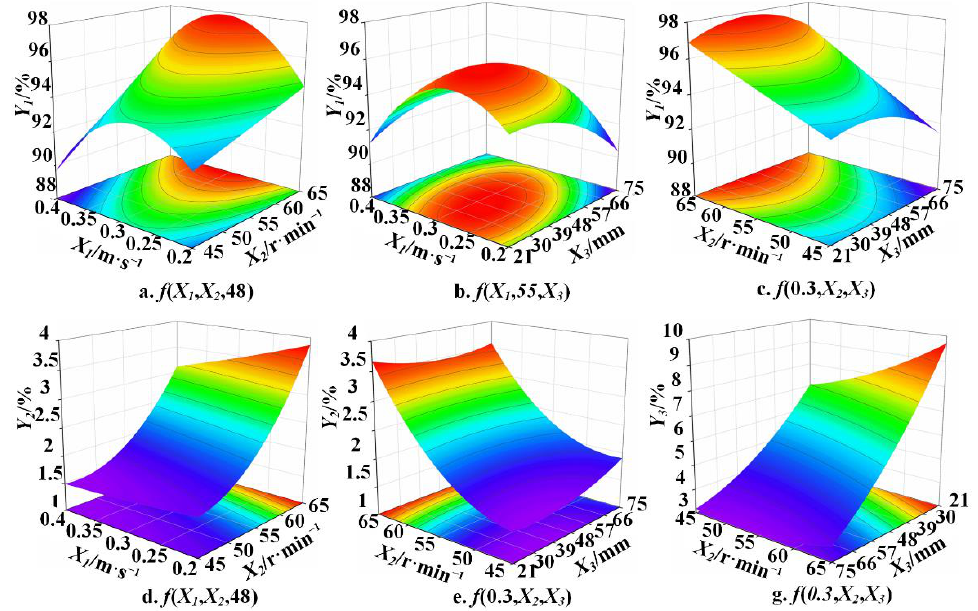
Figure 9. Influence effect of interaction factors on pickup rate Y 1 , breakage rate Y 2 and impurity rate Y 3 . (1) Influence analysis of the pickup